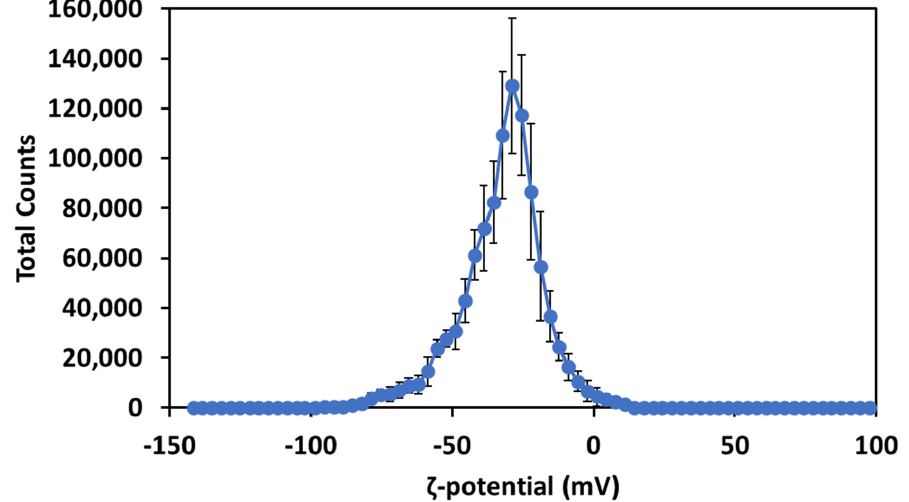
Figure 4. ζ -potential of Cur-AgNPs after